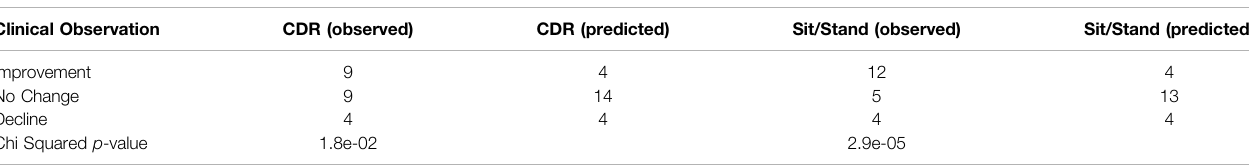
TABLE 5 | Categorical treatment response